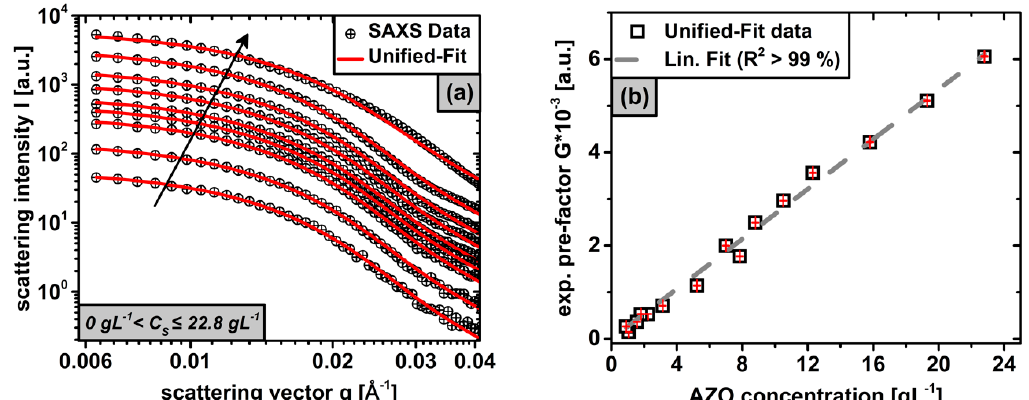
Figure 6. SAXS curves of stable AZO phases, having di ff erent concentrations in the range of 0 gL − 1 < Figure 6 . (cid:1845)(cid:1827)(cid:1850)(cid:1845) curves of stable (cid:1827)(cid:1852)(cid:1841) phases, having different concentrations in the range of C S ≤ 22.8 gL − 1 , at the Guinier area of the mesocrystal level L 2 ( q L 2 < 0.038 A − 1 ) including their 0 (cid:1859)(cid:1838) (cid:2879)(cid:2869) < (cid:1829) (cid:3020) ≤ 22.8 (cid:1859)(cid:1838) (cid:2879)(cid:2869) , at the Guinier area of the mesocrystal level (cid:1838) (cid:2870) ( (cid:1869) (cid:3013)(cid:2870) < 0.038 Å (cid:2879)(cid:2869) ) including associated Unified-Fit approximations ( a ); The exponential pre-factors G L 2 of L 2 determined from the their associated Unified-Fit approximations ( a ); The exponential pre-factors (cid:1833) (cid:3013)(cid:2870) of (cid:1838) (cid:2870) determined Unified-Fit data in ( a ) are plotted over the corresponding AZO concentration and approximated by a from the Unified-Fit data in ( a ) are plotted over the corresponding (cid:1827)(cid:1852)(cid:1841) concentration and linear regression ( b approximated by a linear regression ( b ).